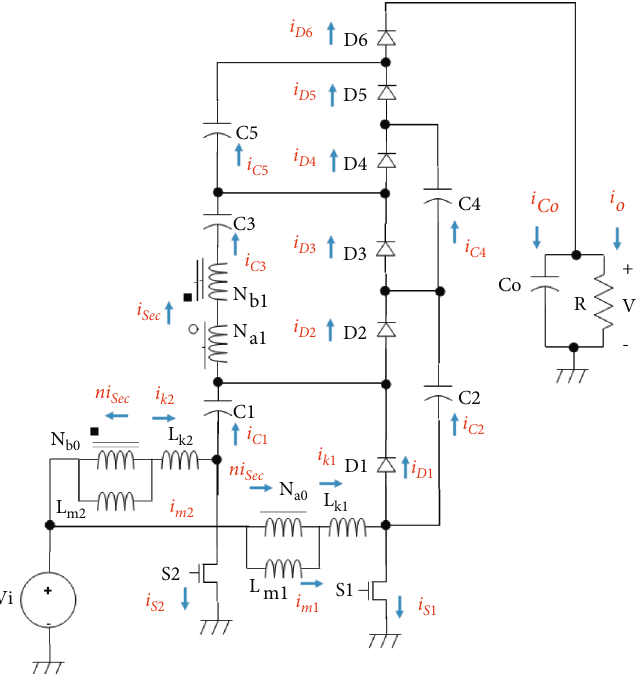
Figure 2: Equivalent circuit of the proposed